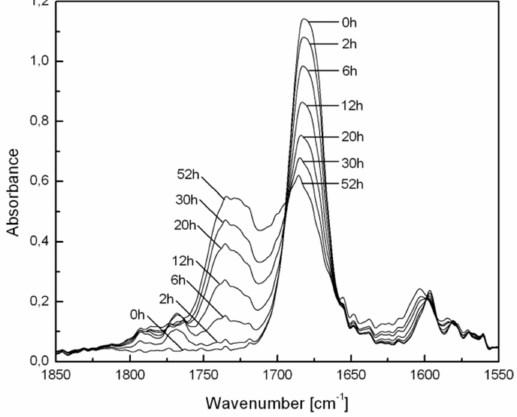
Figure 5. Changes in FTIR spectra of PCOCO /S copolymer film during irradiation ( λ = 366 nm) at room temperature in air. The spectral bands of PS have been subtracted from each for